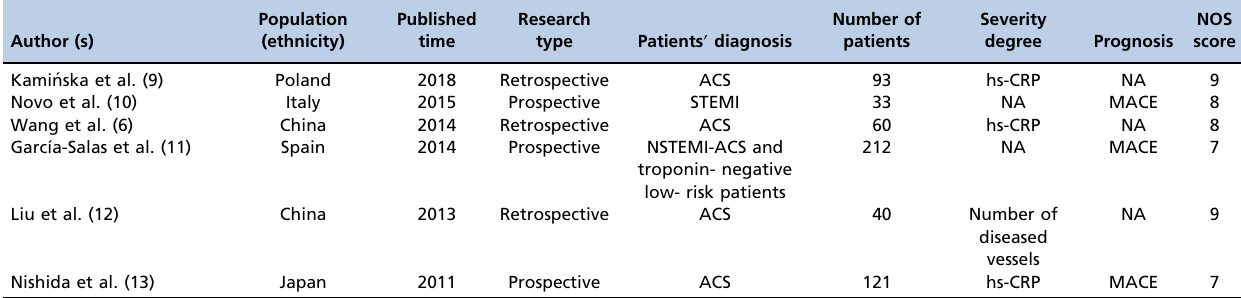
Table 1 - Basic information about the selected studies.